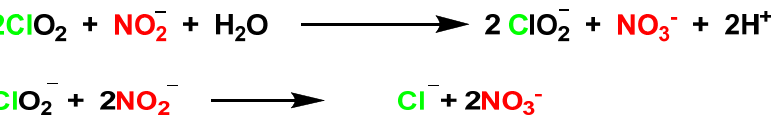
Figure 27. Reaction of hydrogen peroxide with chlorine dioxide.